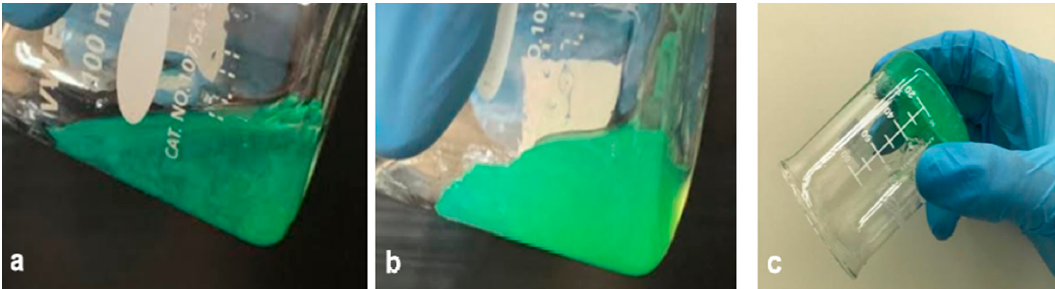
Figure 13. Effect of pH on the gel strength composed of 3.5% NiAc (8260 ppm Ni)/9% PAM, ( a ) pH = Figure 13. E ff ect of pH on the gel strength composed of 3.5% NiAc (8260 ppm Ni) / 9% PaM, ( a ) pH = 6.3, 6.3, ( b ) pH = 8, and ( c ) pH = 12. ( b ) pH = 8, and ( c ) pH =